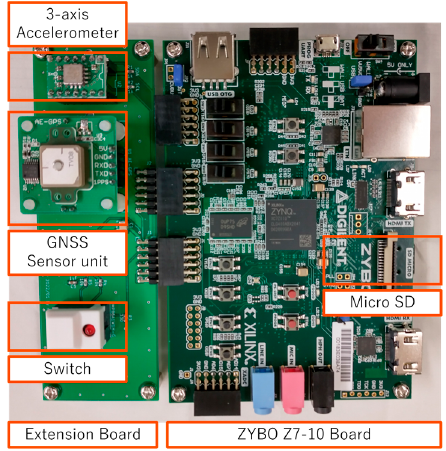
Figure 4. Photograph of the developed sensor in this study.